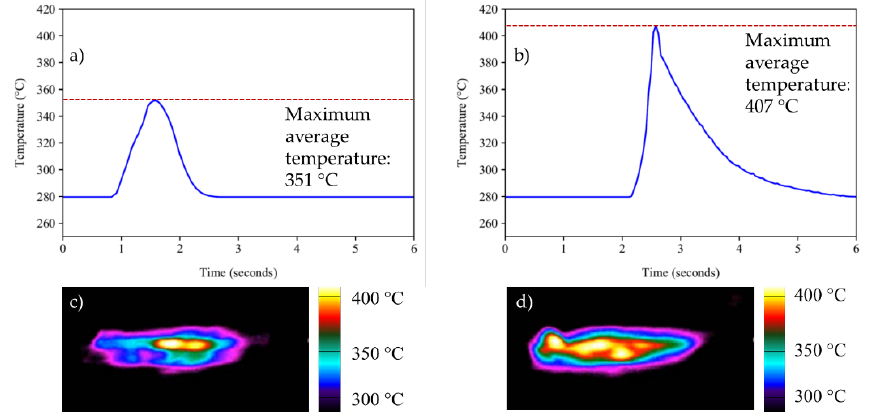
Figure 3. Thermal camera temperature readings at the joint interface and the evolution in the average temperature at the joint interface surface for AZ91 ( a , c ) and AZ91–2Ca ( b , d ) during LFW.